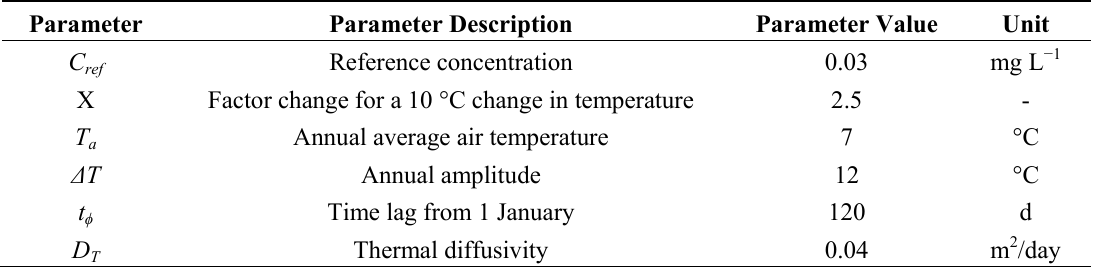
Table 3. Parameter values used for predicting soil temperature and SRP boundaries [Equations (1) and